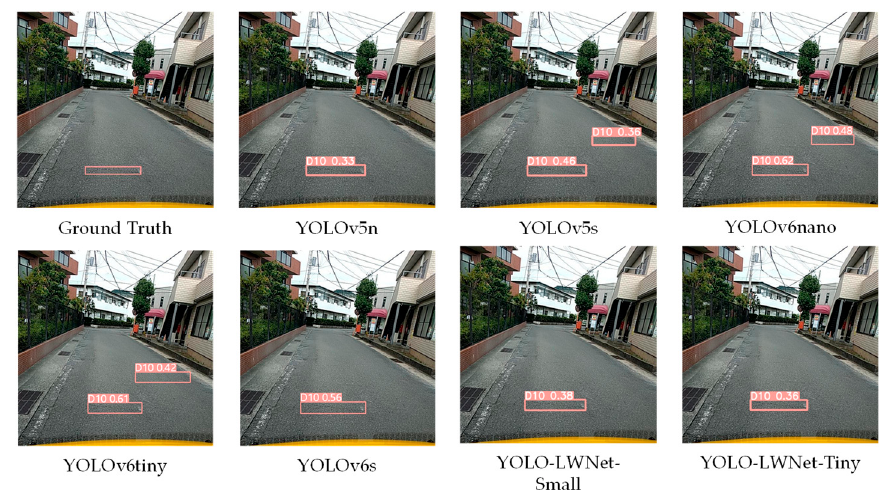
Figure 13. Comparison of the detection of longitudinal cracks (D00).